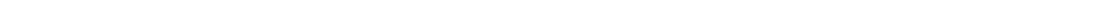
Fig. 6 Artemis acts as a nuclease to promote alt-NHEJ. a ERCC1 is not required for alt-NHEJ. Wild-type or ERCC1-de fi cient U2OS alt-NHEJ-EGFP cells were transfected with indicated siRNAs and then electroporated with pCBASce plasmid. After 48 h, the percentage of GFP-positive cells was determined by FACS. Results represent mean ± SEM of three independent experiments. b Artemis loss reduces the frequency of alt-NHEJ. Wild-type or Artemis-de fi cient U2OS alt-NHEJ-EGFP cells were transfected with indicated siRNAs and then electroporated with pCBASce plasmid. After 48 h, the percentage of GFP- positive cells was determined by FACS. Results represent mean ± SEM of three independent experiments. c Knockdown/knockout ef fi ciency was con fi rmed by western blotting. d The nuclease activity of Artemis is indispensable for its role in promoting alt-NHEJ. Artemis-de fi cient U2OS alt-NHEJ- EGFP cells stably expressing wild-type Artemis or the nuclease-inactivating mutant (H35AD37N) were transfected with indicated siRNAs and then electroporated with pCBASce plasmid. After 48 h, the percentage of GFP-positive cells was determined by FACS. Results represent mean ± SEM of three independent experiments. e Artemis loss suppresses gross genomic instability in BRCA2-depleted cells. Wild-type or Artemis-de fi cient HeLa cells were transfected with indicated siRNAs, exposed to 10 Gy IR, and then allowed to recover for 2 or 24 h before being processed for immuno fl uorescence. Representative RPA2/RAD51 foci and DAPI-stained nuclei are shown. f Quanti fi cation of RPA2/RAD51 foci and nuclear fragmentation. Data represent mean ± SEM of three independent experiments. Over 100 cells were counted in each experiment. g The nuclease activity of Artemis is indispensable for its role in promoting gross genomic instability in BRCA2-de fi cient cells. Artemis-de fi cient HeLa cells stably expressing wild-type Artemis or the nuclease- inactivating mutant (H35AD37N) were transfected with indicated siRNAs, exposed to 10 Gy IR, and then allowed to recover for 24 h before being processed for immuno fl uorescence. Representative RPA2/RAD51 foci and DAPI-stained nuclei are shown. h Quanti fi cation of RPA2/RAD51 foci and nuclear fragmentation. Data represent mean ± SEM of three independent experiments. Over 100 cells were counted in each experiment. i The expression of wild-type Artemis or its H35AD37N mutant was con fi rmed by western blotting. Scale bars, 10 μ